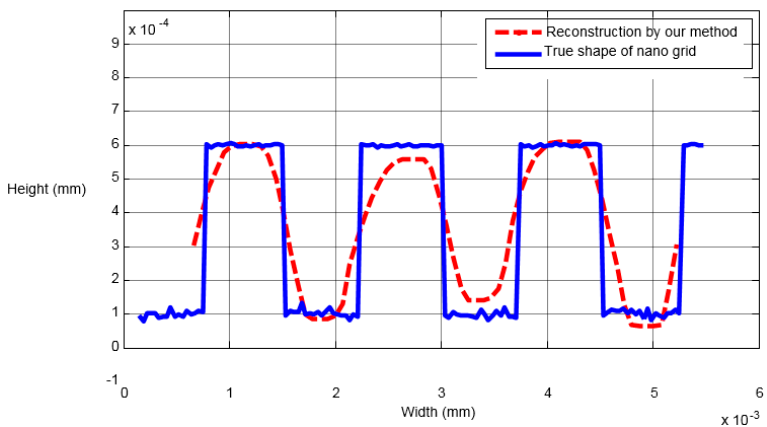
Figure 10. The comparison of an arbitrary section.